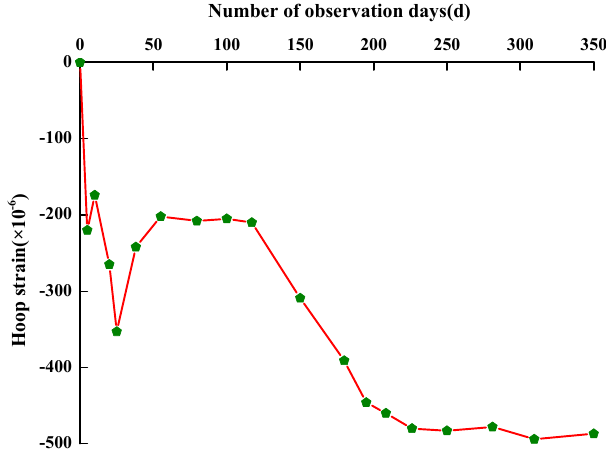
Figure 14. Hoop strain of the shaft lining concrete in the field over time.